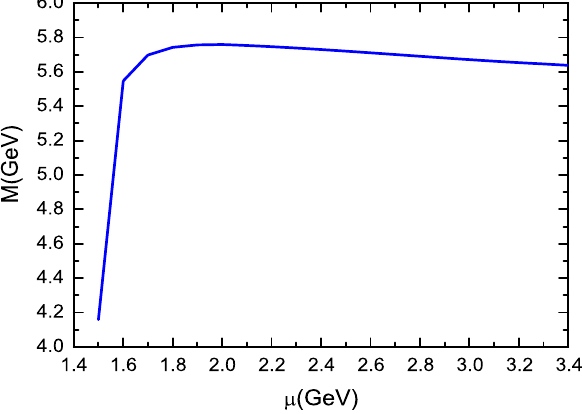
Fig. 8 The mass M X ( cc ¯ c ¯ c , 0 ++ ) with variation of the energy scale μ from Eqs. (29,